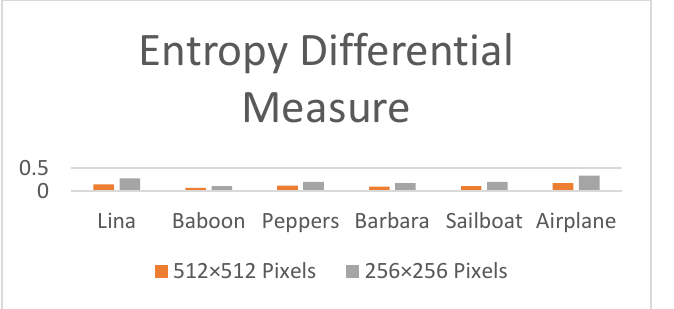
Figure 9. Entropy differential measure for embedding 2000 bytes in colour images of sizes 512 × 512 and 256 × 256.